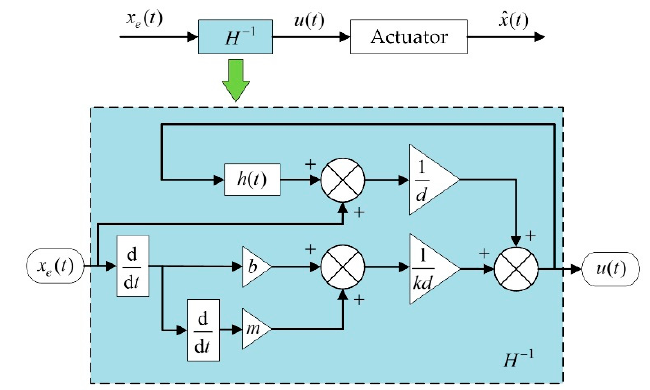
Figure 8. Block diagram of the feedforward compensator.